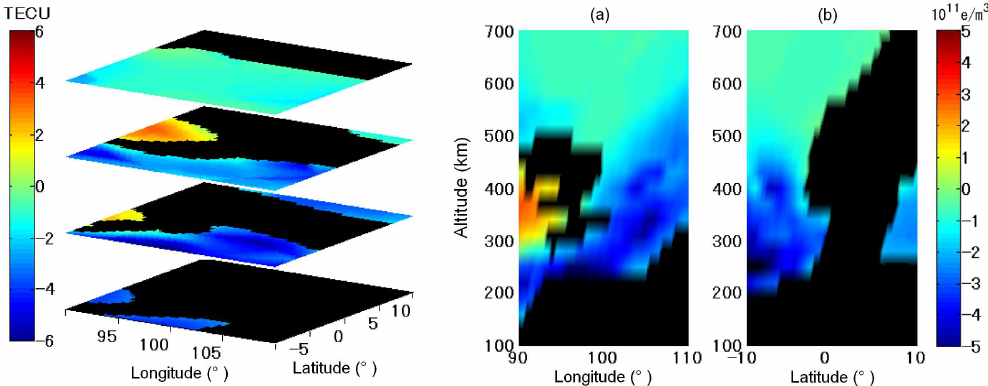
Fig. 12. Example of electron density distribution in which the electron density exceeds the IQR (07:30–07:45UT). Black areas indicate region in which the electron density is smaller than the IQR. Left panel indicates the IECs. (a) Longitudinal difference in electron density between the observed data and the reference data at the same latitude of epicenter (4.520 ◦ S). (b) Latitudinal difference in electron density between the observed data and the reference data at the same longitude of the epicenter (101.374 ◦